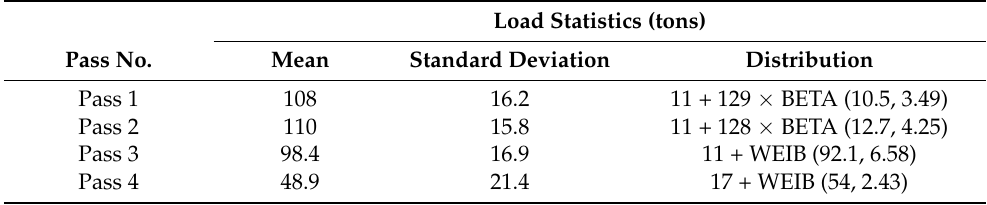
Table 5. Best operator bucket load statistics 1 .